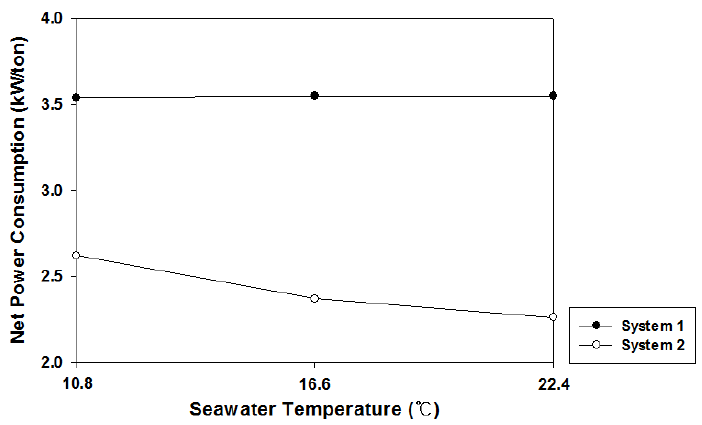
Figure 11. Specific net power consumption at different seawater temperatures.